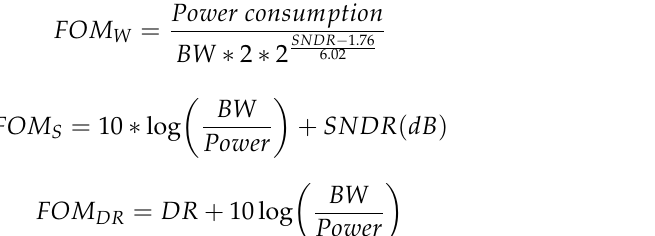
Figure 20. The proposed ΔΣ modulator’s dynamic range.